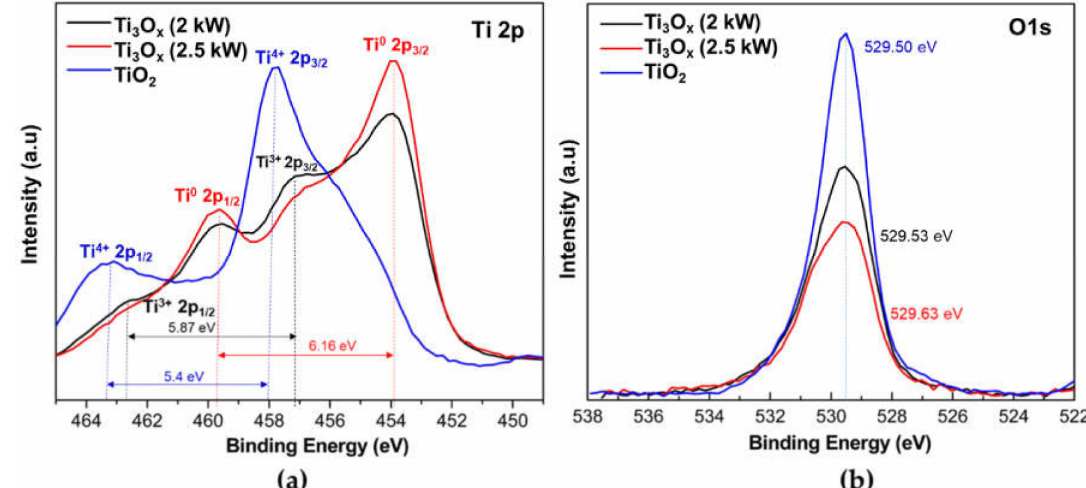
Figure 5. X-ray photoelectron spectroscopy of ( a ) Ti2p and ( b ) O1s spectra obtained from Ti 3 O x thin films deposit at 2 and 2.5 kW and TiO 2 thin films as a reference.